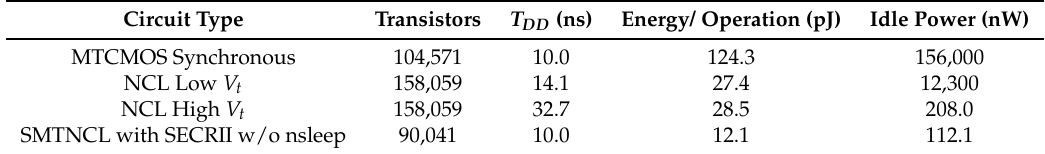
Table 2. Multi-Threshold NULL Convention Logic (MTNCL) Comparison